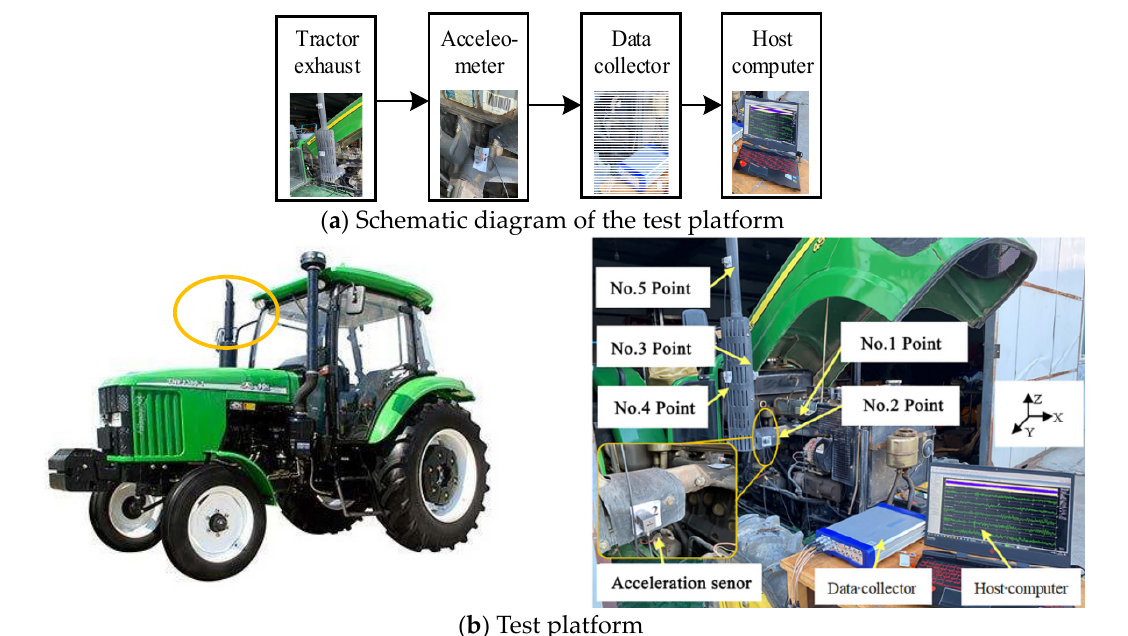
Figure 2. Vibration test. Table 2. INV3062S data acquisition instrument.